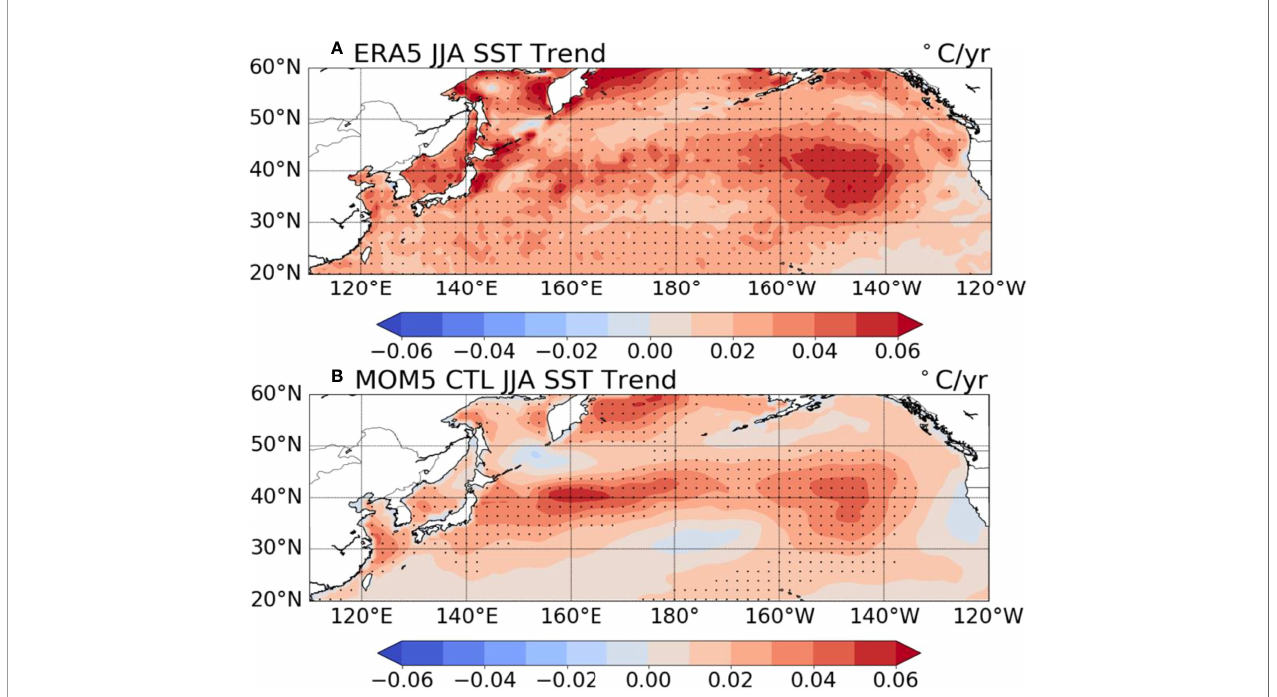
FIGURE 5 | (A) The map of increasing and decreasing trend from 1982 to 2020 of ERA5 SST in the Paci fi c region during summer. (B) MOM5 Exp_CTL SST trend. The dots on the map mean a signi fi cant increase in the 95% con fi dence